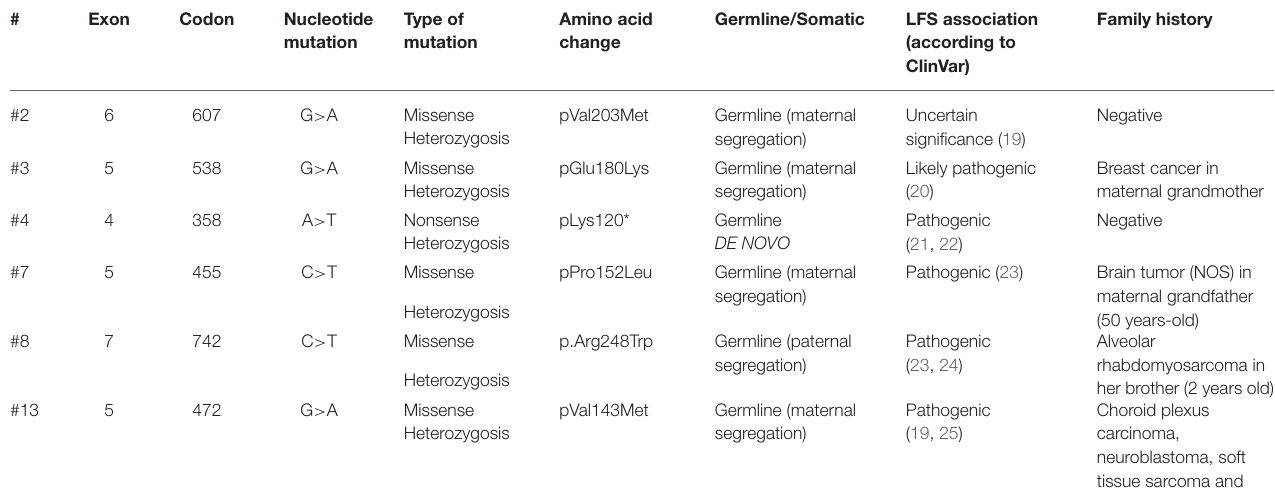
TABLE 4 | Genetic finding: TP53 mutations features in tested patients.